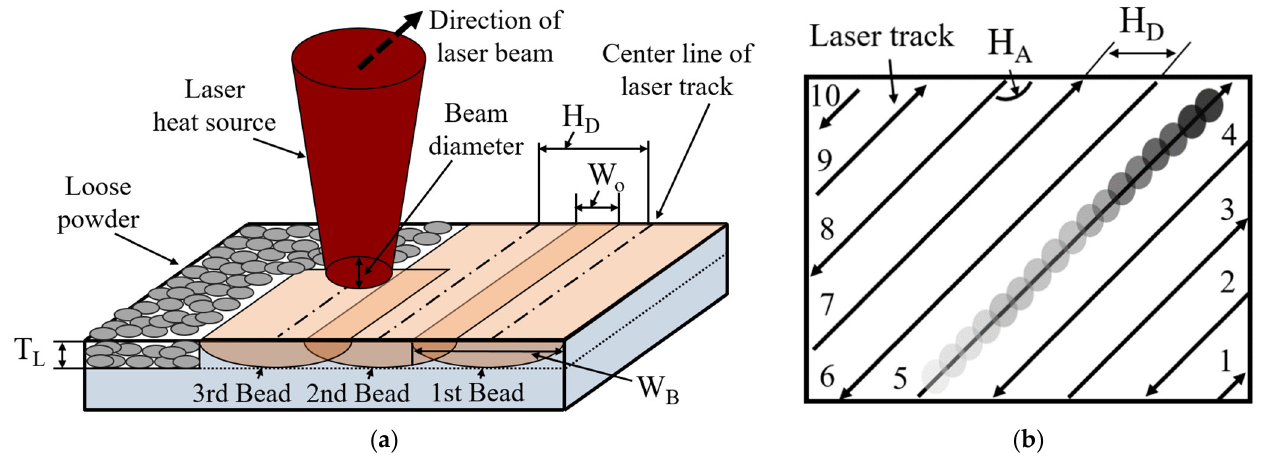
Figure 4. Conceptual diagram of a cuboid deposition experiment: ( a ) conceptual diagram of deposition process and ( b ) conceptual diagram of the toolpath.